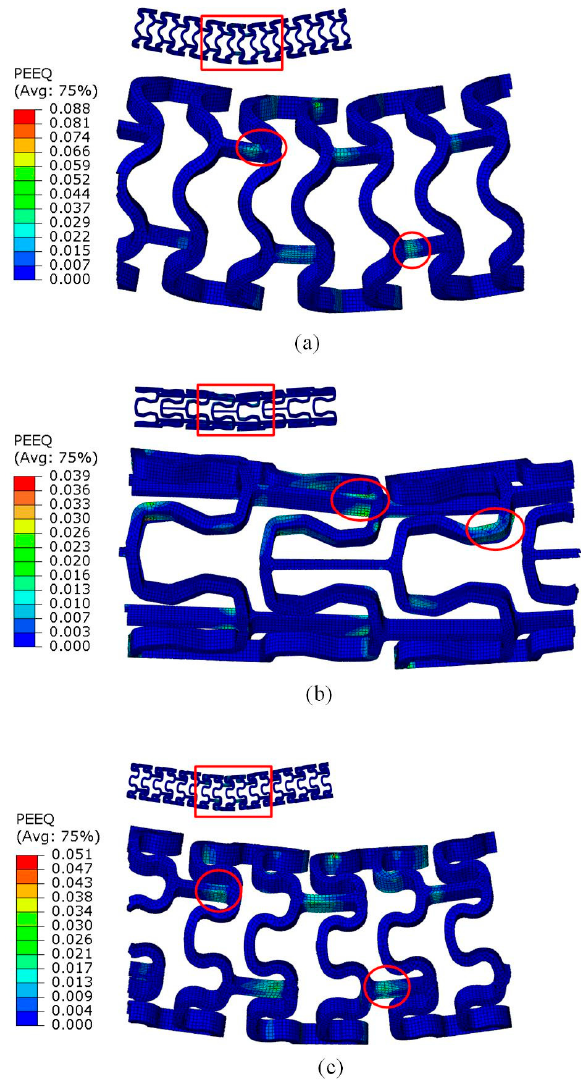
Figure 19. Equivalent plastic strain distributions of ( a ) Stent A, ( b ) Stent B, and ( c ) Stent C upon unloading after three-point bending to a deflection of 1.4 mm.